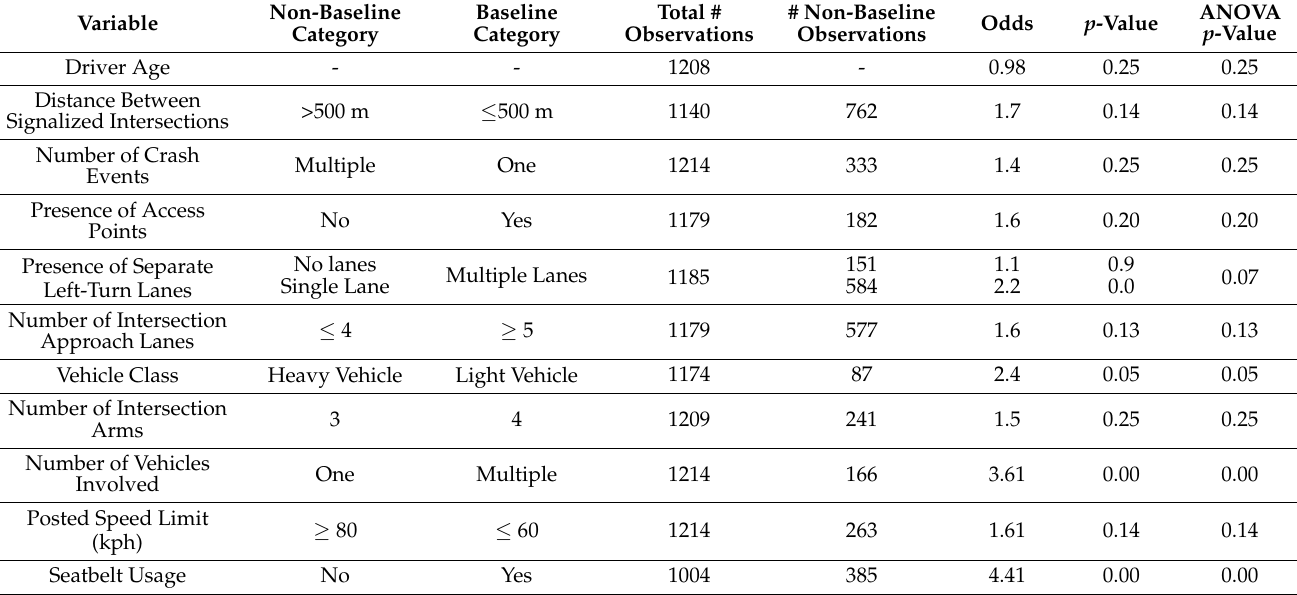
Table 4. Univariate Analysis: Signalized